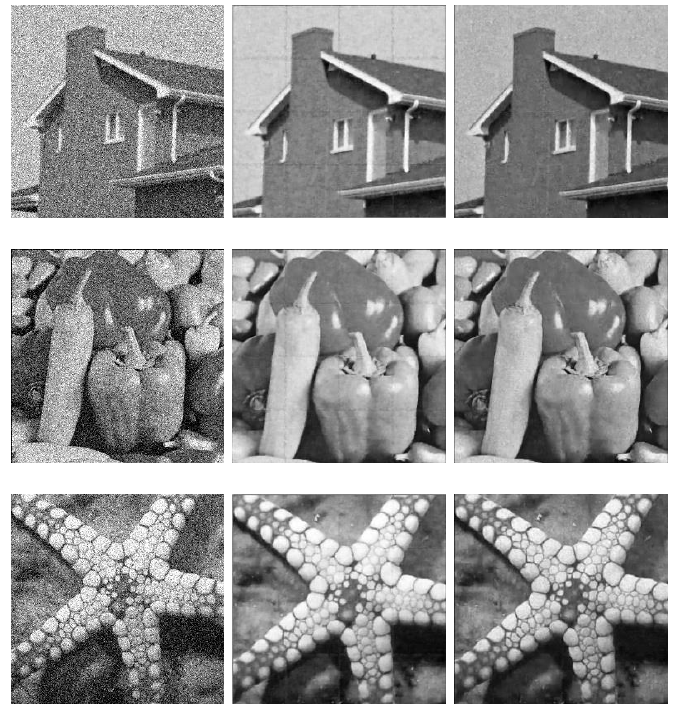
Figure 7. Several denoised image results with noise level 35. From left to right, the first column shows the noisy images, the second column shows the restored image of ResNet, and the last column shows the restored images of FbResNet.